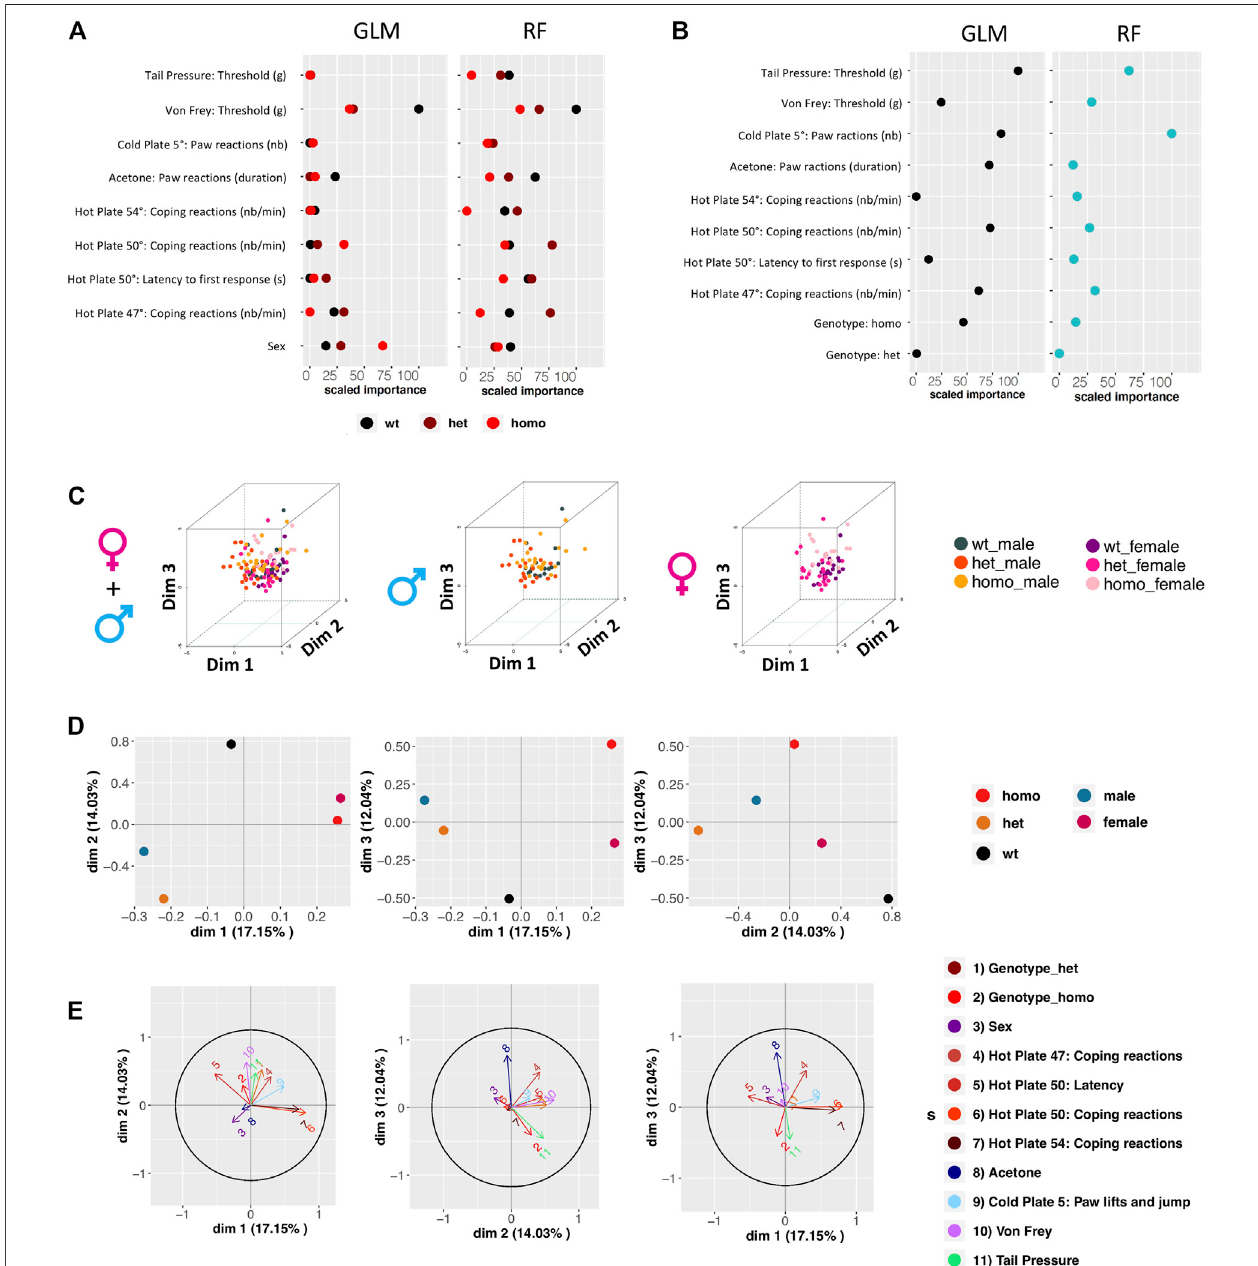
FIGURE 5 | Gdaphen analyses to identify the variables contributing more to genotype and sex discrimination considering the three genotypes together, based on phenotypicdata. (A) Identi fi cationofthepowerofeachexplanatoryphenotypicvariabletothegenotypediscrimination.Theexplanatoryvariablesselectedweretheones known to contribute more than a 30% to the genotype discrimination. Those variables were identi fi ed using a principal component analysis (PCA) after applying a multifactoranalysisofmixeddata(MFA)implementedusingMFAmixfunctionfromthePCAmixdataRpackage(https://arxiv.org/abs/1411.4911).Therelevanceof those variables to the genotype discrimination was analyzed using two different statistical classi fi ers: Generalized linear models, noted as GLM taken from the caret R package, and Random forest, noted RF taken from the caret R package (Max Kuhn (2020). Caret: Classi fi cation and Regression Training. R package version 6.0-86. https://CRAN.R-project.org/package (cid:1) caret)). All measures of importance are scaled to have a maximum value of 100 in the variable contributing the most to the discrimination. With GLM and RF, we can identify the importance of each variable to discriminate each genotype. (B) Identi fi cation of the power of each explanatory phenotypicvariableknowntocontributemorethana30%tothegenotypediscrimination,analyzedtoseetheexistenceofdifferentresponsesbasedonthesexusingthe two different statistical classi fi ers. All measures of importance are scaled to have a maximum value of 100 in the variable contributing the most to the discrimination. (C) 3D-PCA plots showing the individual animals clustering on the 3D space based on the PCA analyses performed with all the phenotypic variables and colored based on genotype and sex. On the left panel showing the three genotypes and two-sex individuals, on the middle plot showing only male data, and on the right plot only female